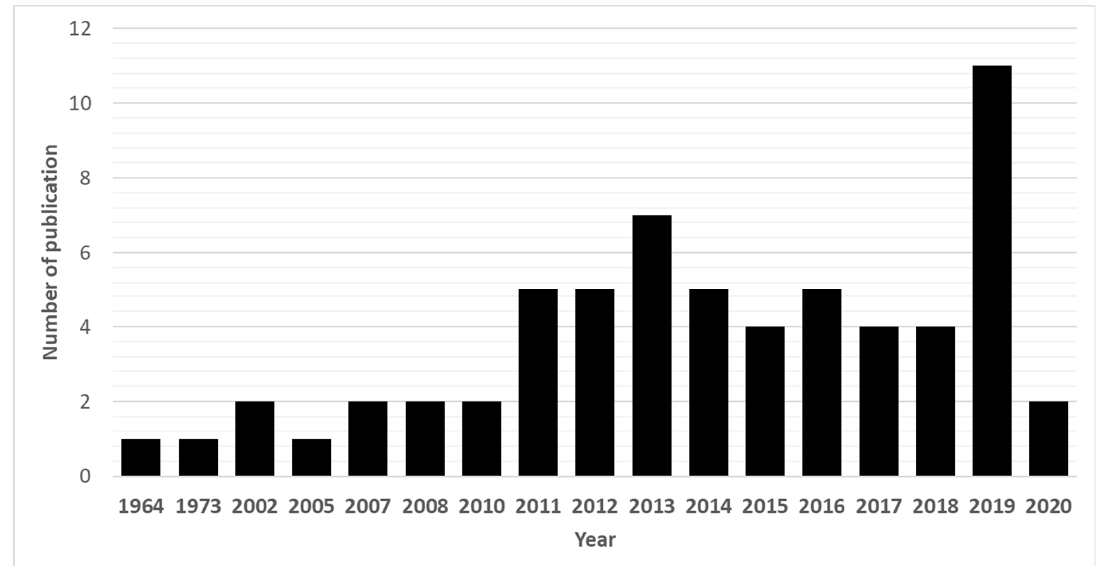
Figure 2. Annual number of anthelmintic papers published from 1964 to 2020 according to PubMed—situation as of July 2020.